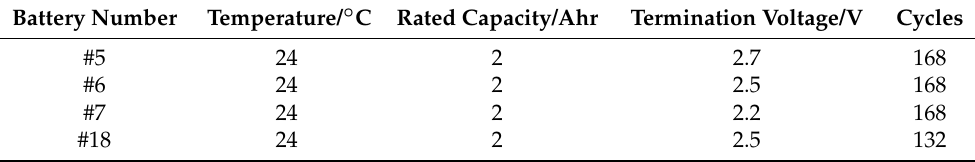
Table 2. The battery-specific parameters of the